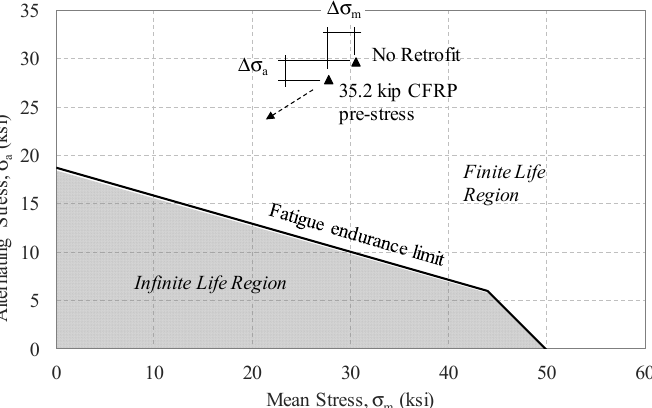
Figure 13. Goodman life diagram with the stress shift change of section F13 with the retrofit applying 35.2 kips of pre-stress force.